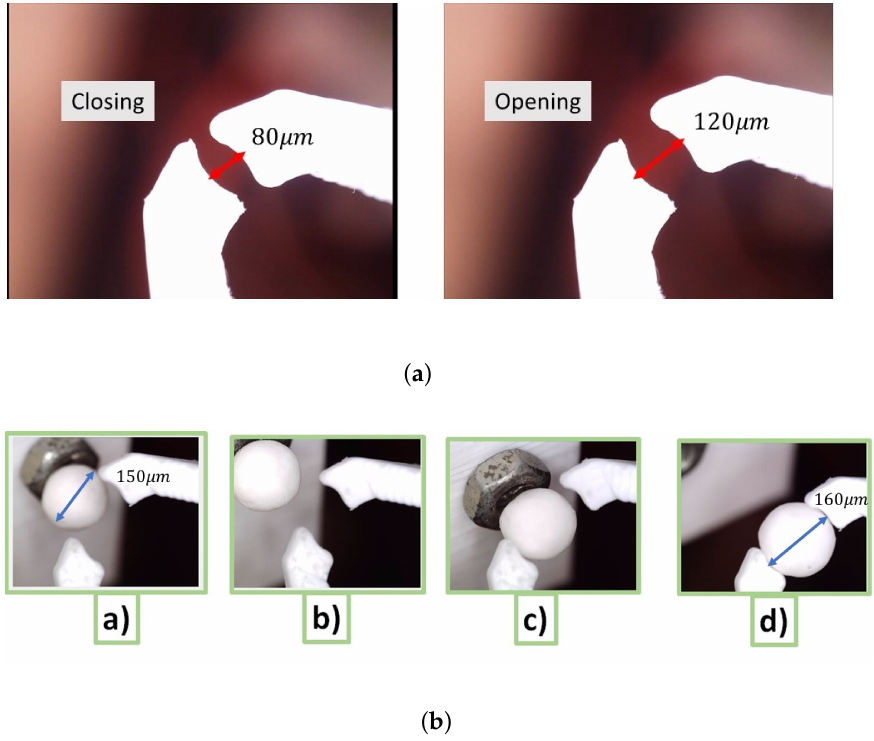
Figure 9. ( a ) Direct visualization of the gripper section attached to the piezolectric actuators; ( b ) manipulation of a 160 µ m polystyrene sphere using the gripping device made with the piezoelec- tric